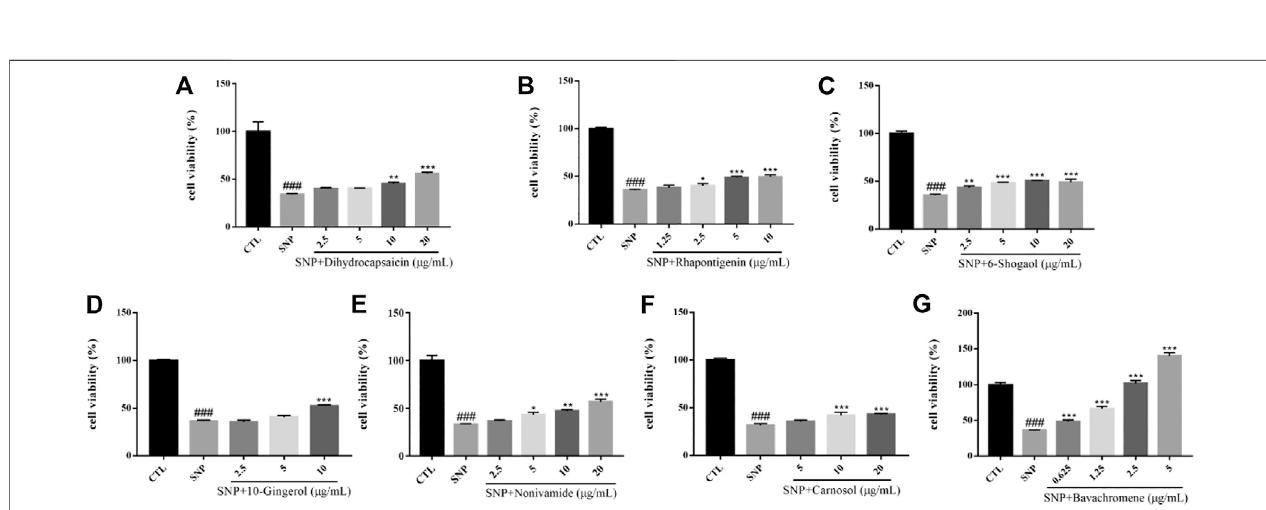
FIGURE 11 | Various constituents suppressed SNP-induced cytotoxicity in SH-SY5Y cells. Cells were pre-treated with different concentrations of Dihydrocapsaicin (A) , Rhapontigenin (B) , 6-Shogaol (C) , 10-Gingerol (D) , Nonivamide (E) , Carnosol (F) , Bavachromene (G) or 0.1% DMSO for 2 h and then incubated with or without SNP (600 μ M) for 24 h and the cell viability was detected by MTT assay. Results are shown as the mean ± SEM and represent three independent experiments. ### p < 0.001 compared with control group, * p < 0.05, ** p < 0.01, *** p < 0.001 compared with SNP treated group.